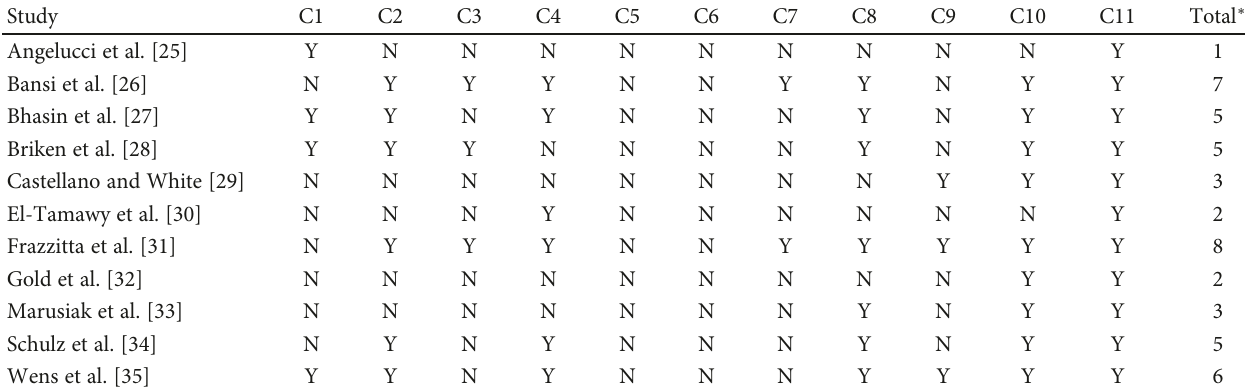
Table 2: Quality assessment of the included studies using the PEDro checklist ∗